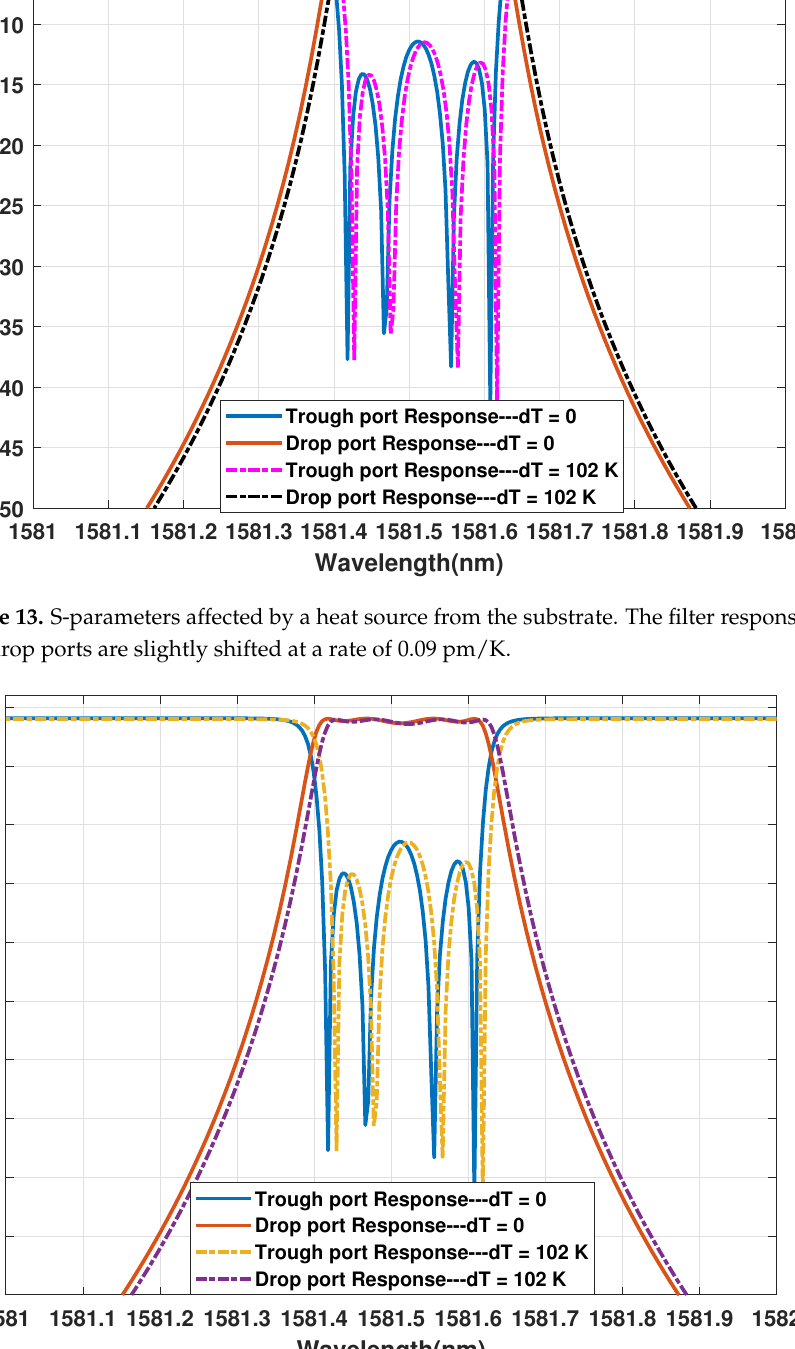
Figure 14. S-parameters affected by a variation of ambient temperature. The filter responses at through and drop ports are slightly shifted at a rate of 0.11 pm/K